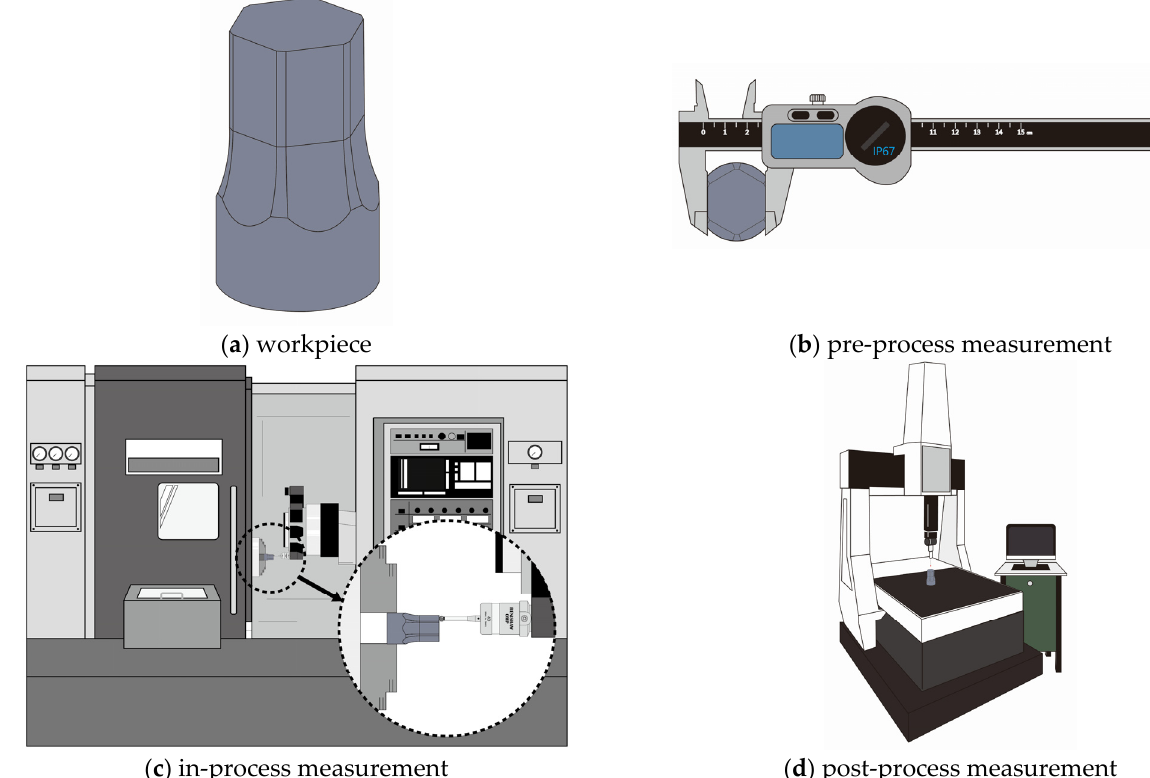
Figure 1. Schematic diagram of workpiece measurement technology ( a ) workpiece; ( b ) pre-process measurement; ( c ) in-process measurement; ( d ) post-process measurement.